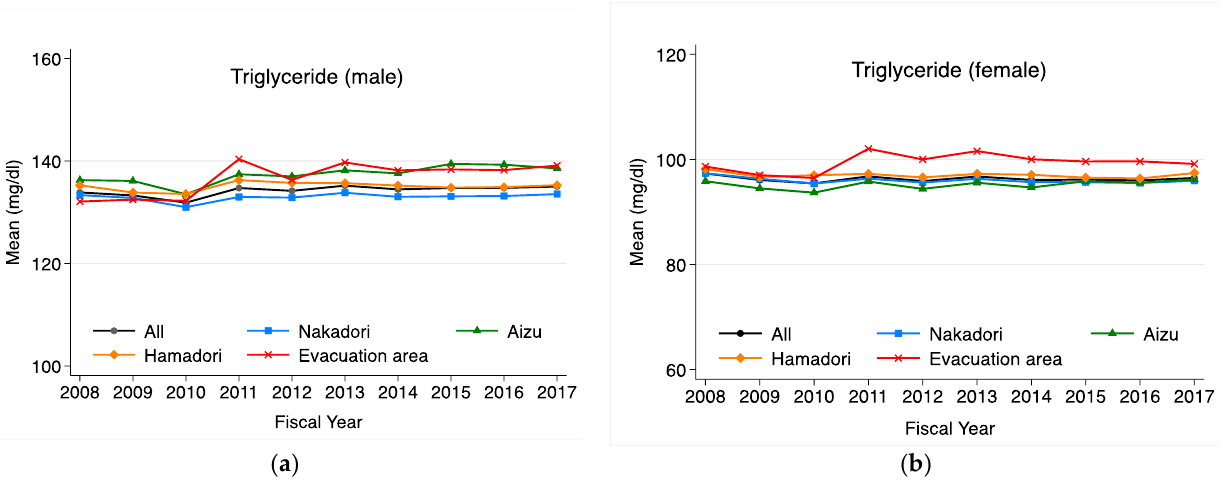
Figure 3. ( a ) Annual trends in age-adjusted mean triglyceride levels for males in each region. ( b ) Annual trends in age-adjusted mean triglyceride levels for females in each region. In addition to the four regions, trends for Fukushima Prefecture as a whole are also shown.